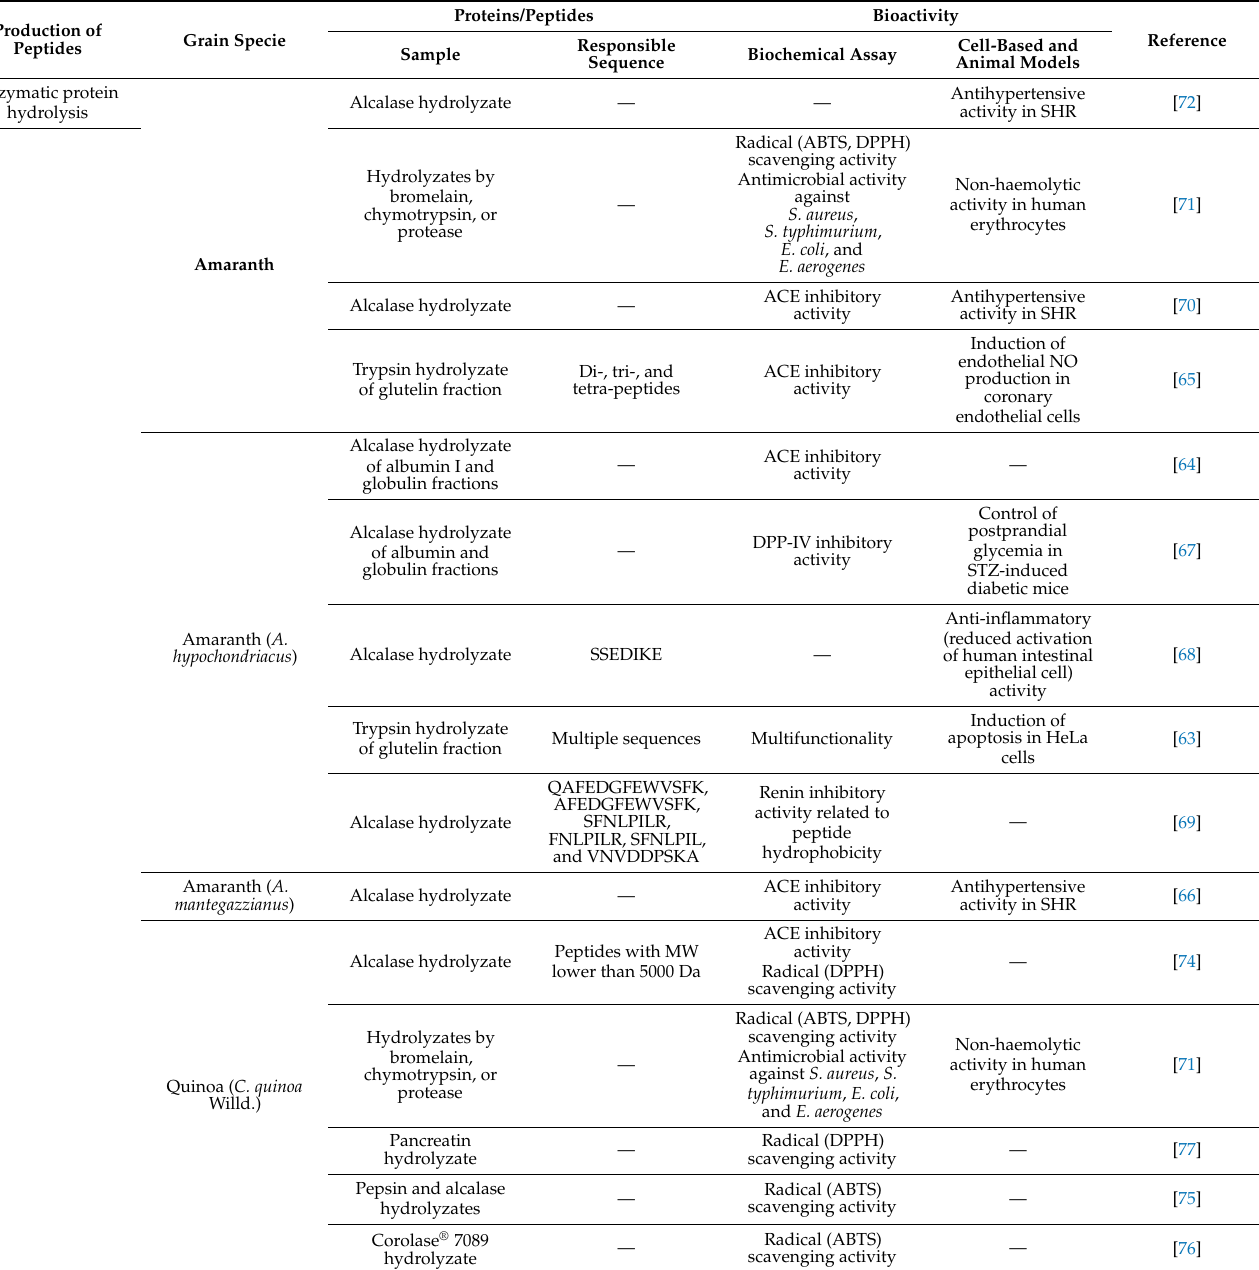
Table 3. Evaluation of production and health effects of proteins, hydrolyzates and bioactive peptides derived from underutilized